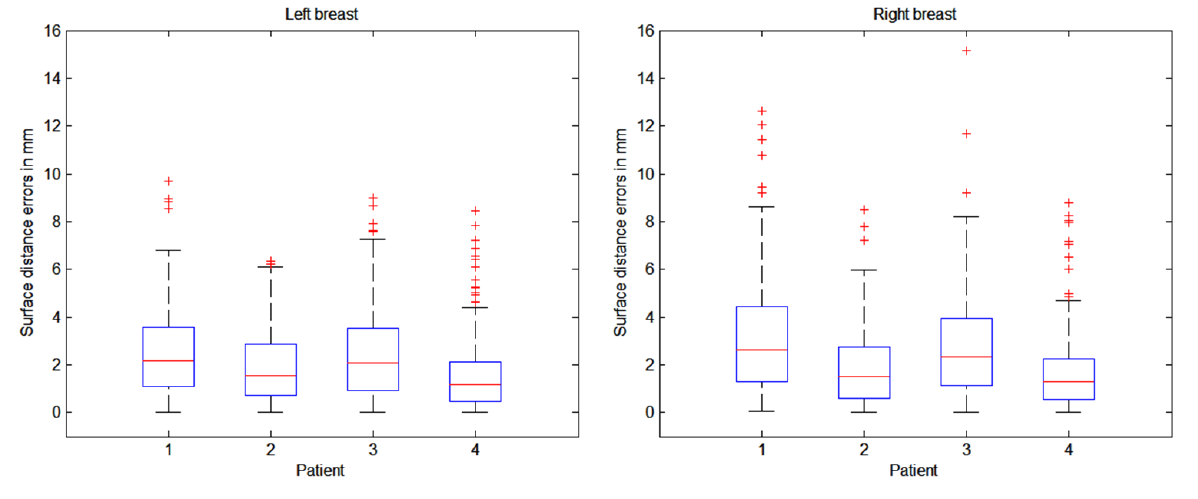
Figure 10. Postoperative simulation results predicted from preoperative images compared with postoperative laser